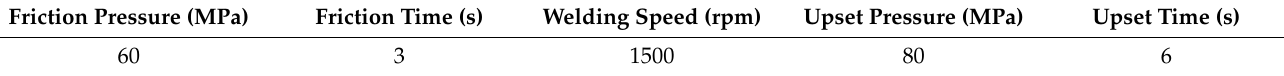
Table 2. Friction welding